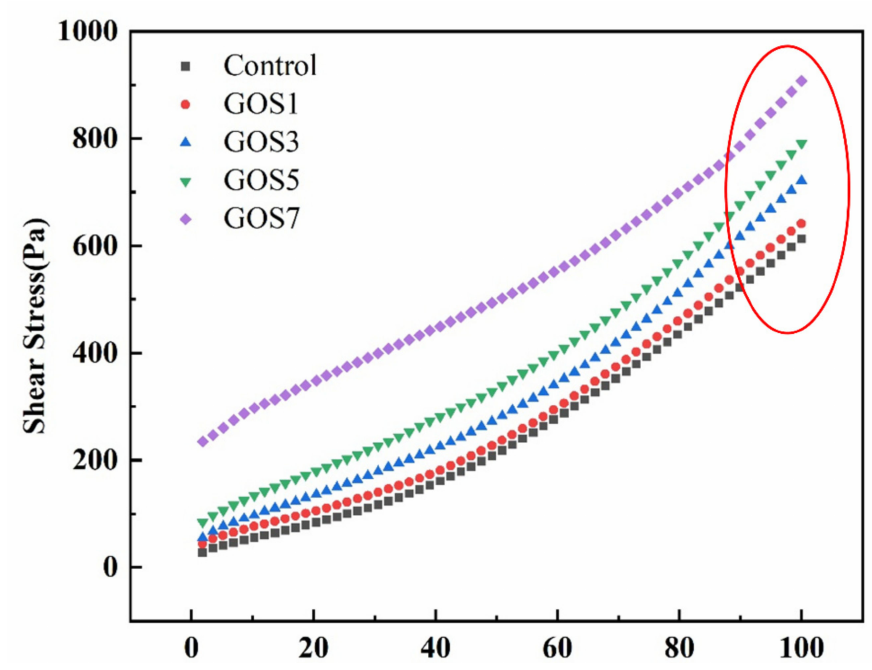
Figure 7. H-B fitting curves of shear rate-shear stress of fresh cement pastes with different GOS